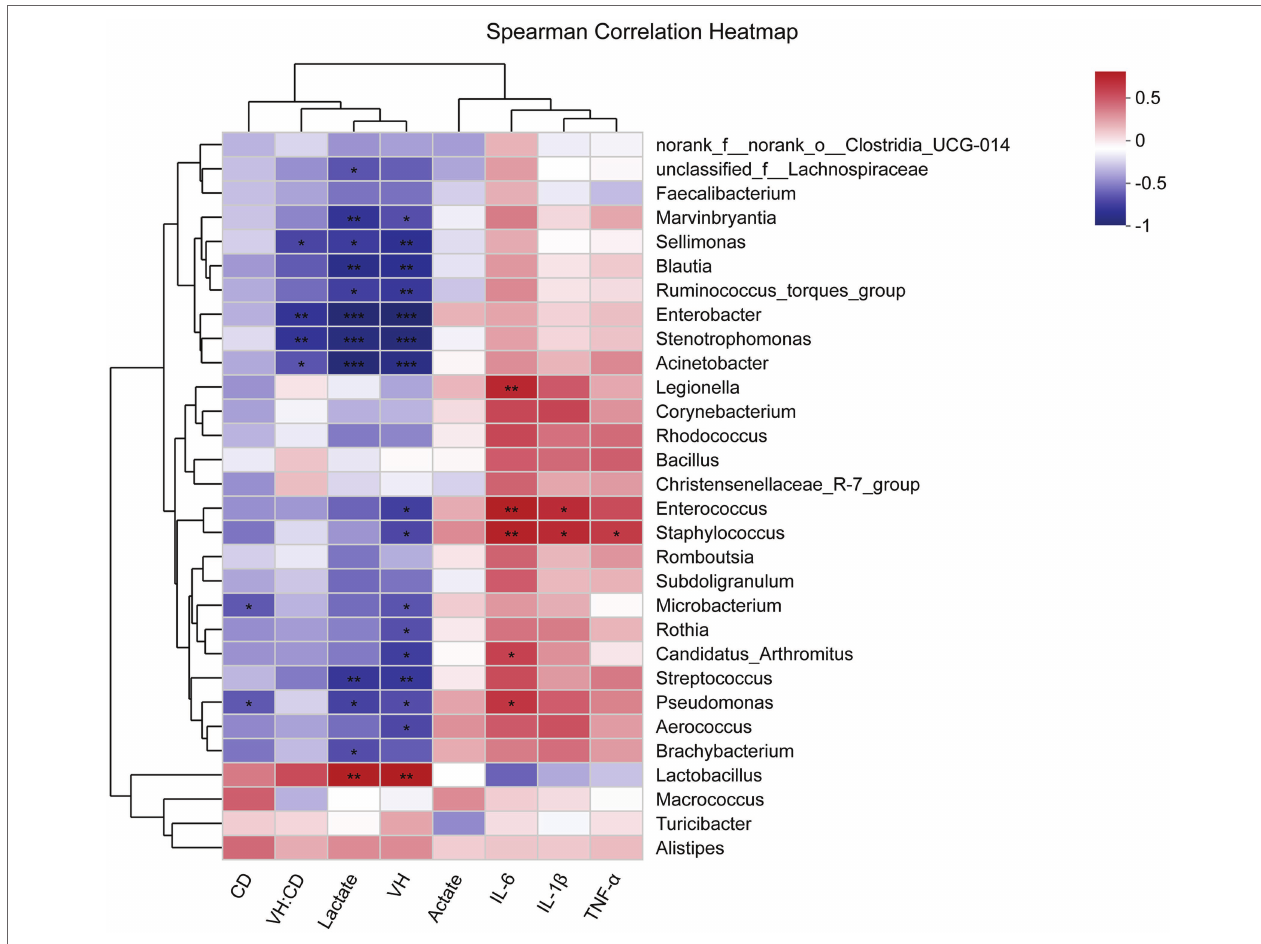
FIGURE 7 | Heatmap of spearman’s correlation between ileal microbiota, metabolites, morphology, and immune factors. The correlation was analyzed based on the relative abundance of 30 phylotypes at genus level. The blue suggests a negative correlation, and the red suggests a positive correlation. The “*”